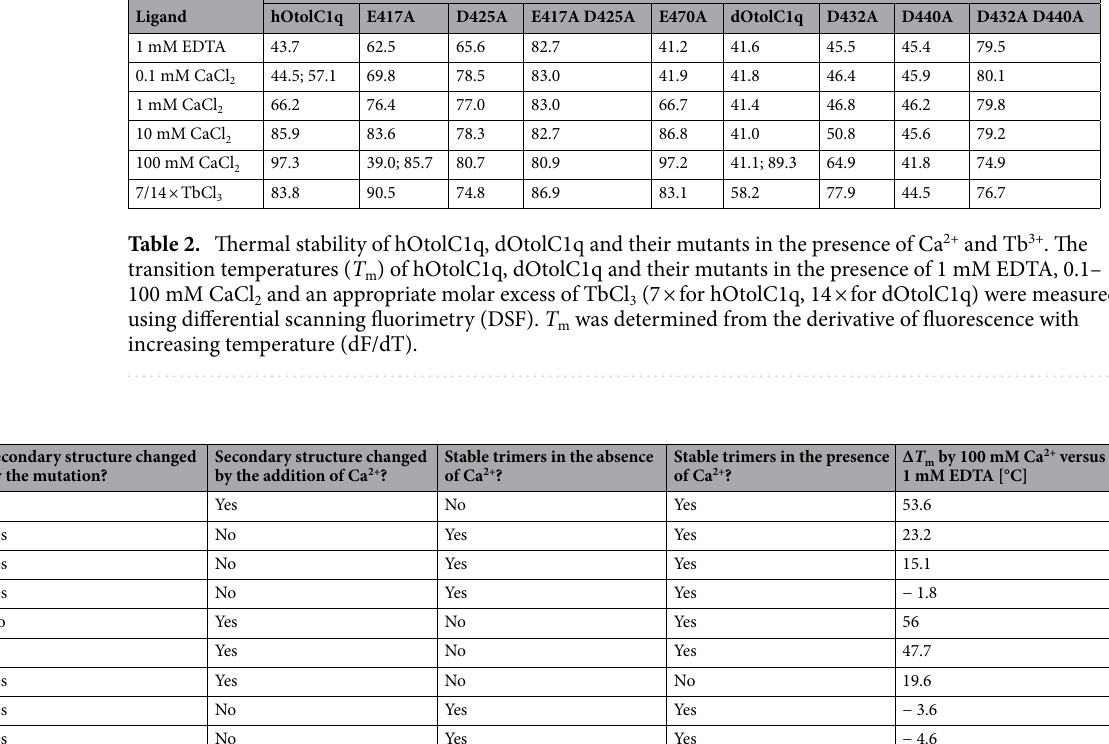
Table 3. Summary of the effects of the mutations on the structure of hOtolC1q and dOtolC1q and their interactions with Ca 2+ .